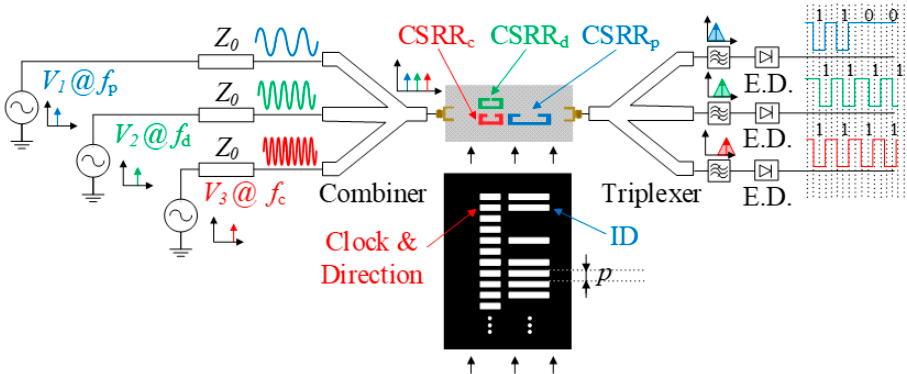
Figure 4. Schematic of the proposed reader/encoder system, based on all-dielectric encoders, with synchronous reading and motion direction detection capability.